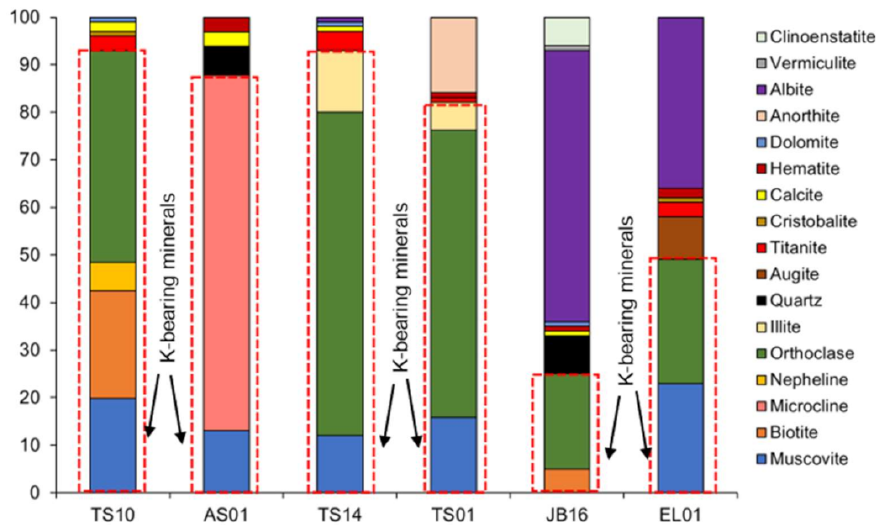
Figure 4. Mineralogical composition of the raw samples using XRD analysis.